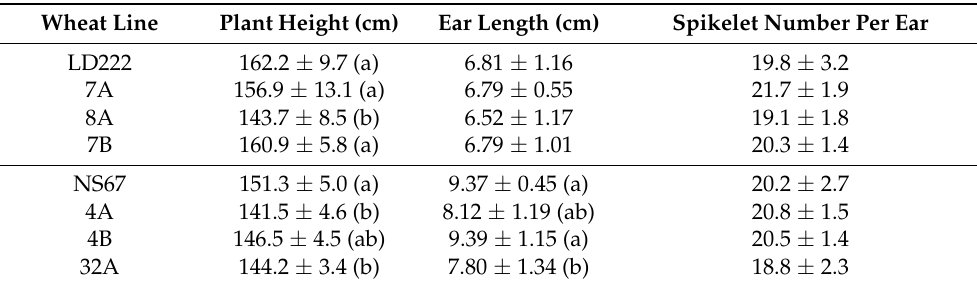
Table A3. Average morphometric measurements of durum- and bread-wheat selected features with the corresponding standard deviations (n = 10). Different letters indicate a significant difference at p < 0.05, as determined using one-factor ANOVA followed by Tukey’s test.